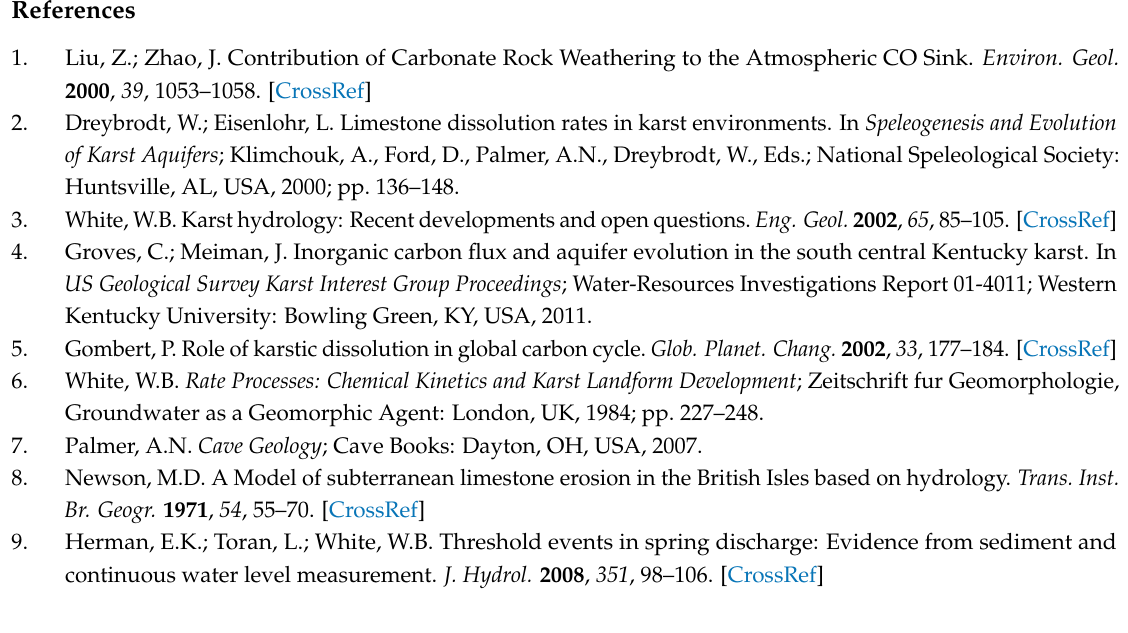
Figure S1: Correlation between depth measured using YSI Sonde and depth measured using Sontek Sonde; Figure S2: Correlation between discharge measured at USGS location and calculated using the Sontek Sonde; Figure S3: Correlations between concentration of major cations and specific conductance; Figure S4: Correlation between total suspended solids (TSS) and turbidity; and Table S1: regression statistics for Ca 2+ and SpC, Mg 2+ and SpC, and HCO 3 − 1 and SpC. Time series and discrete events sampling data are available at: https://data.